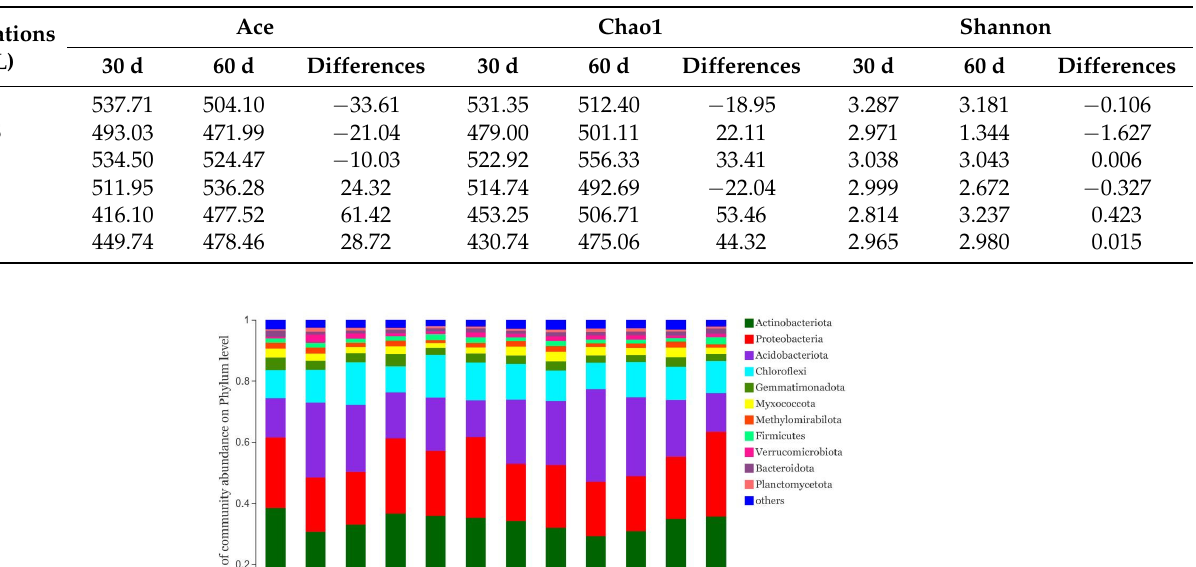
Table 5. Effect of pyrogallic acid on fungal diversity.